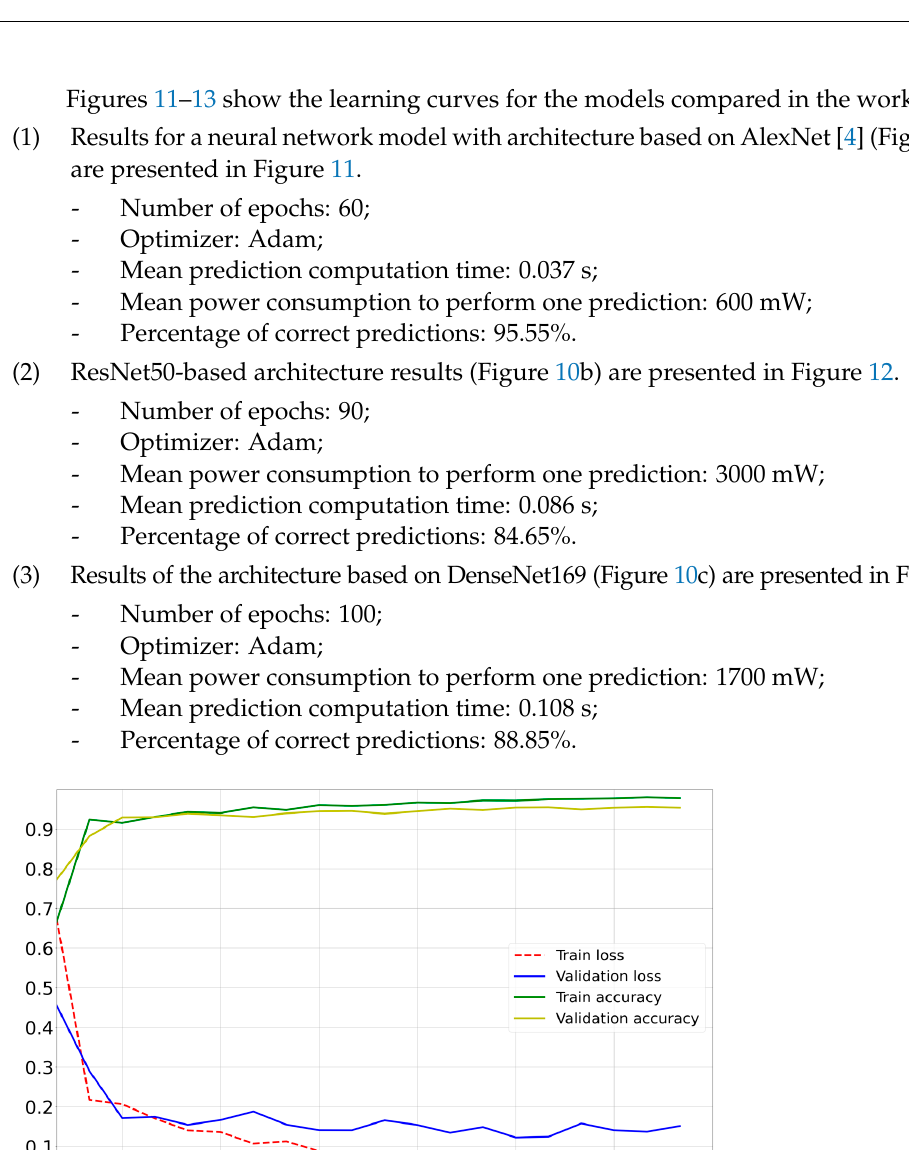
Figure 11. Loss curves of the model in Figure 9b (green and yellow) and accuracy curves (blue and red).